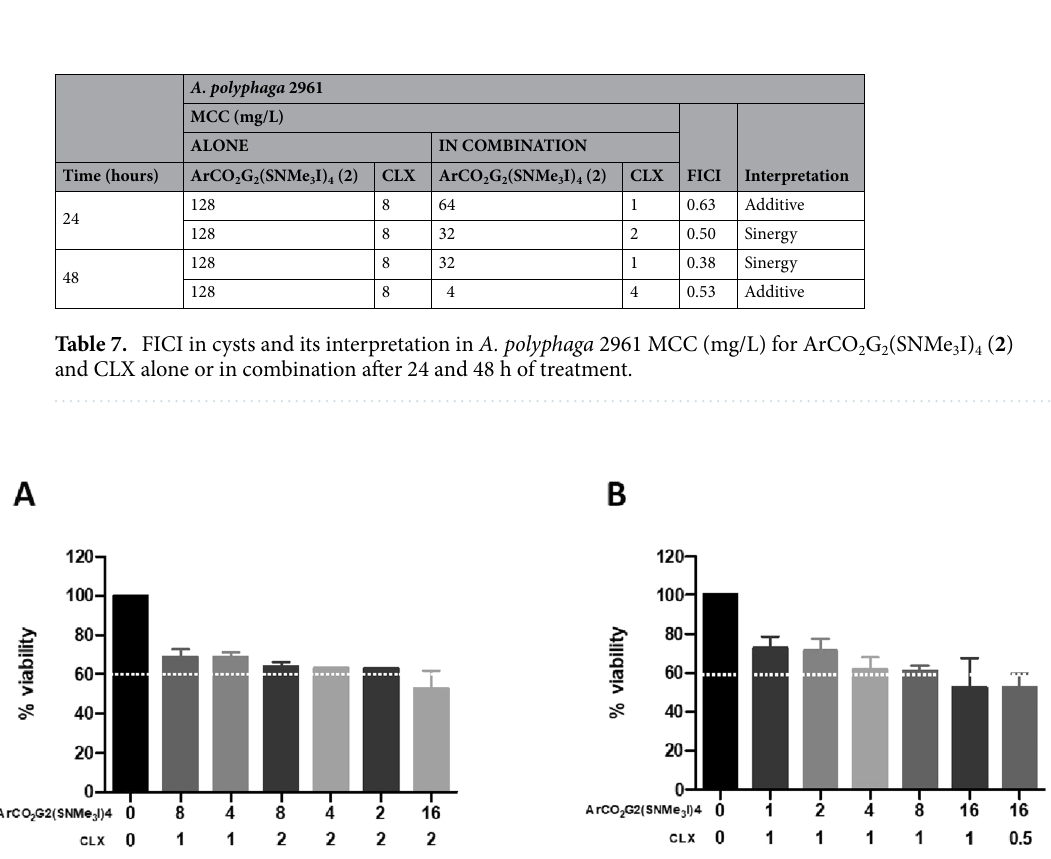
Table 6. FICI in cysts and its interpretation in A. griffini MYP2004. MCC (mg/L) for ArCO 2 G 2 (SNMe 3 I) 4 ( 2 ) and CLX alone or in combination after 24 and 48 h of treatment.